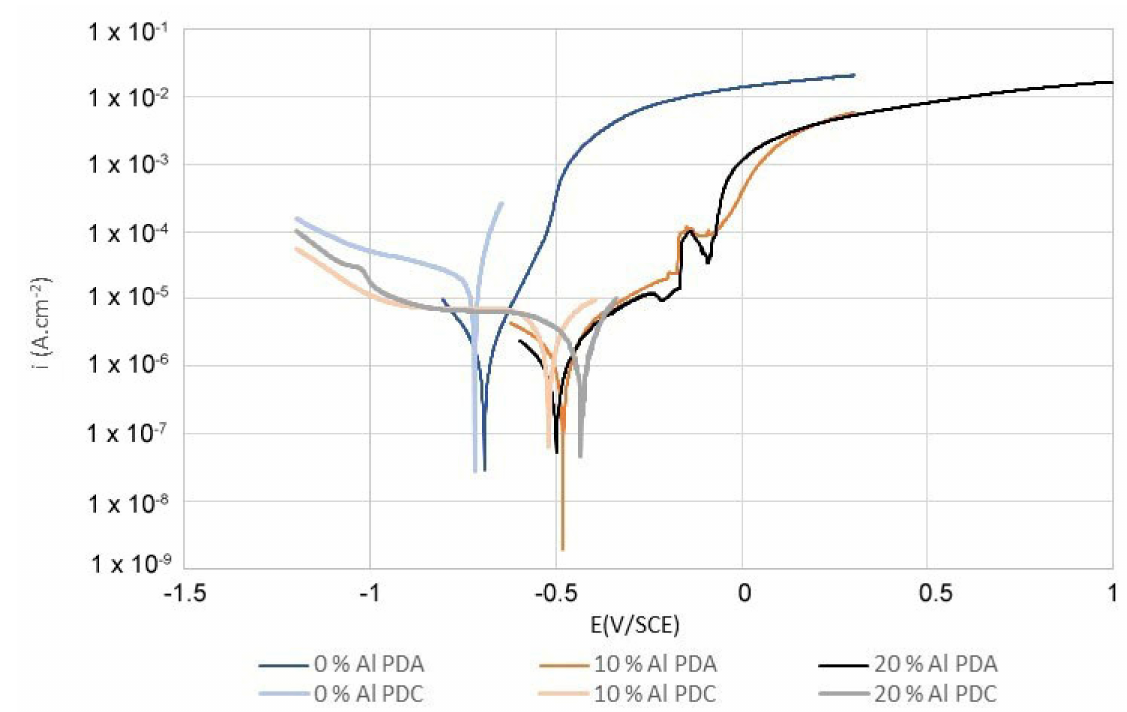
Figure 3. Comparison of PDA curves in model